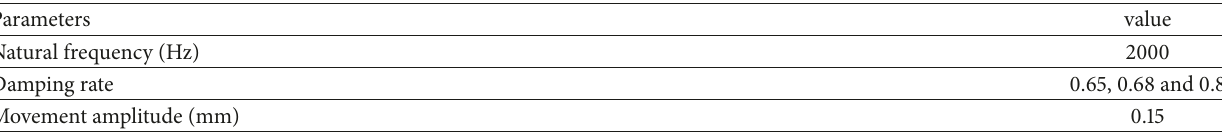
Table 1: Parameters of piezoelectric